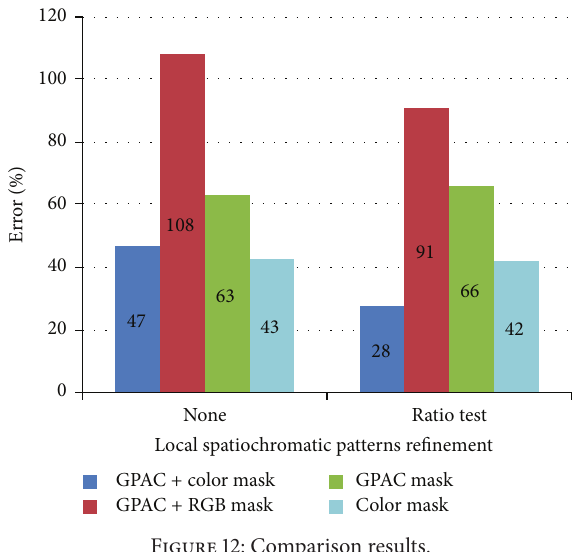
Figure 12: Comparison